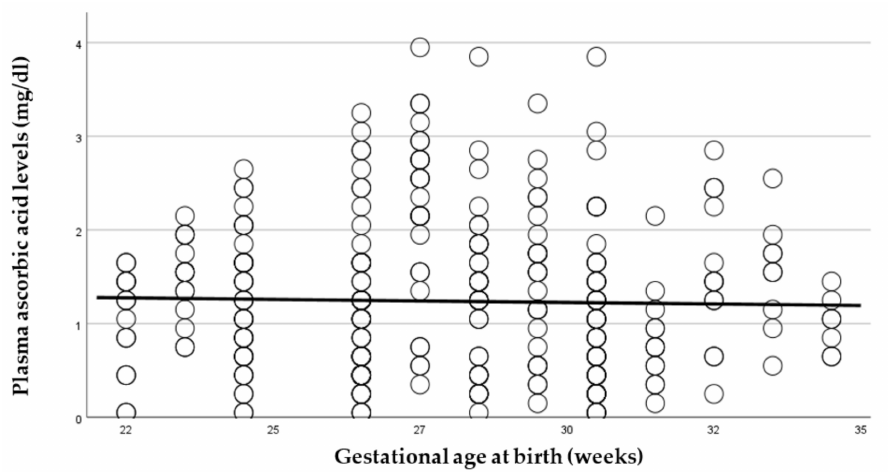
Figure 4. Measured plasma ascorbic-acid levels (mg/dL) in relation to gestational age at birth (weeks). With increased gestational age at birth, plasma ascorbic-acid levels were significantly lower ( p <